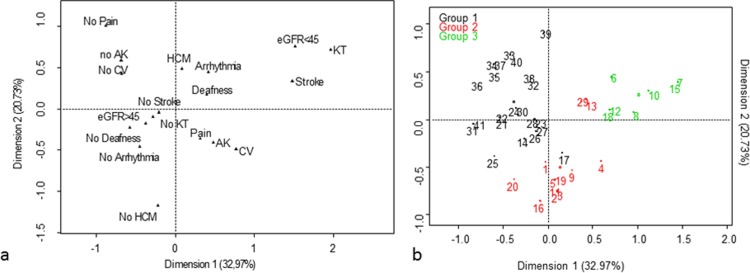
a: Variable factor map obtained by multiple component analysis using data for 41 males with complete data (AK: angiokeratoma; CV: cornea verticillata; eGFR: estimated glomerular filtration rate in ml/min/1.73 m2; HCM: hypertrophic cardiomyopathy; KT kidney transplantation). b: Ascending hierarchical classification of individuals using the first 5 dimensions of multiple component analysis performed using data for 41 males with complete data. Three clusters were identified. Group 1, characterized by the absence of cornea verticillata (p<10−7), the absence of angiokeratoma (p<10−4), the absence of acral pain (p<0.001) and the absence of renal disease, was referred to as the nonclassical cluster. Groups 2 and 3, characterized by the presence of cornea verticillata (p<0.002), were referred to as classical groups with younger (mean age 32.3 +/- 9.9 years) and older (mean age 48.8 +/- 9.5 years) patients, respectively.